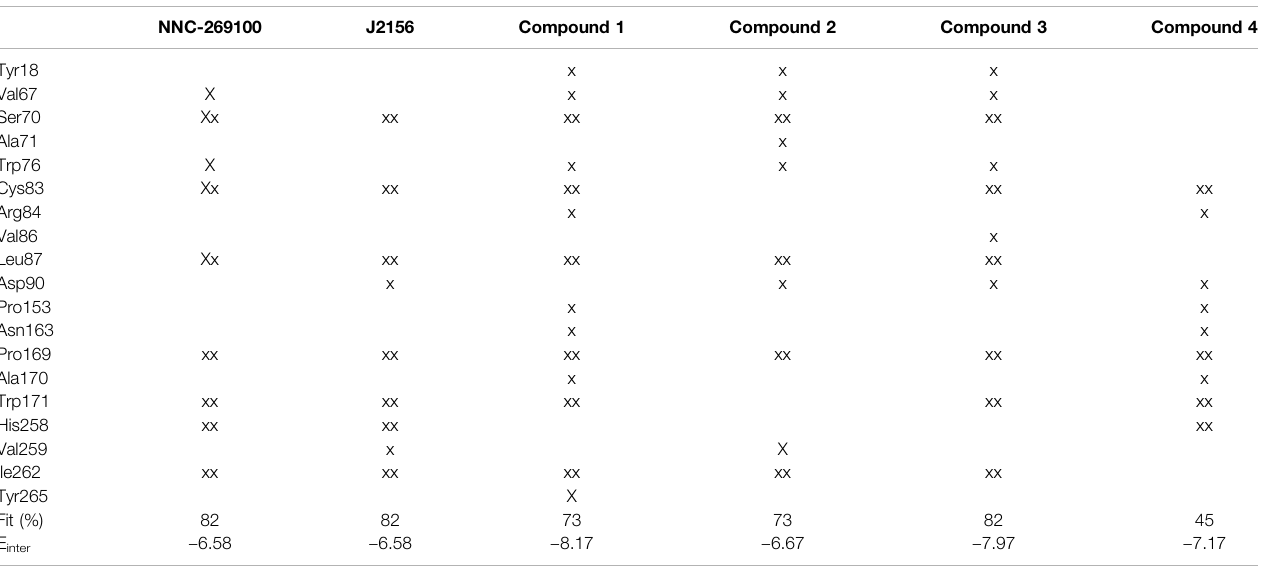
TABLE 1 | Target residues interacting with representative docked ligand structures within 3.5